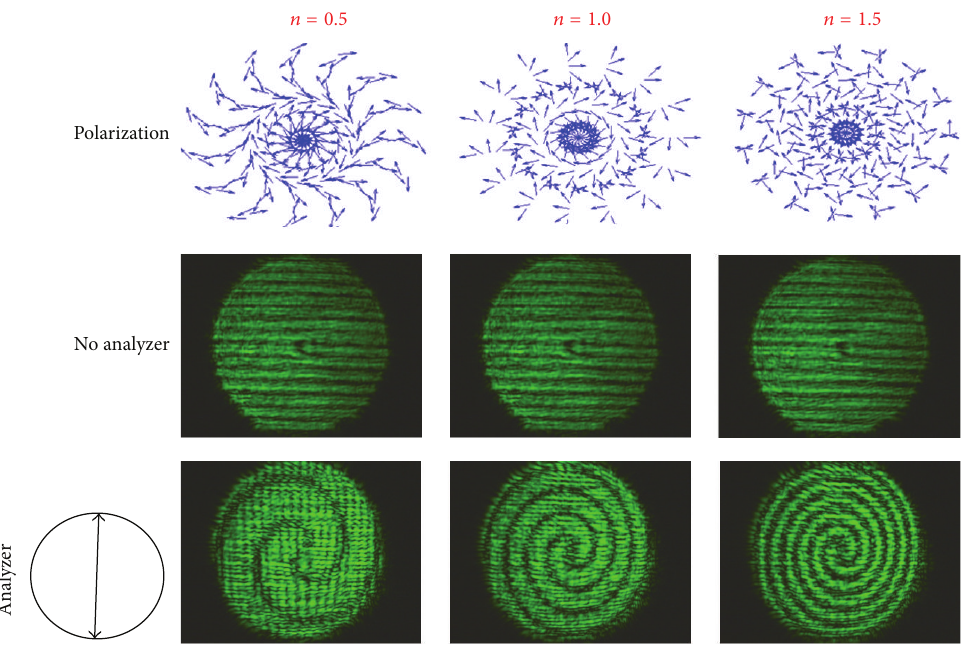
Figure 5: Cylindrical vector beams with topological charge 𝑚 = 1 and radial numbers 𝑛 = 0.5, 1.0 and 𝑛 = 1.5